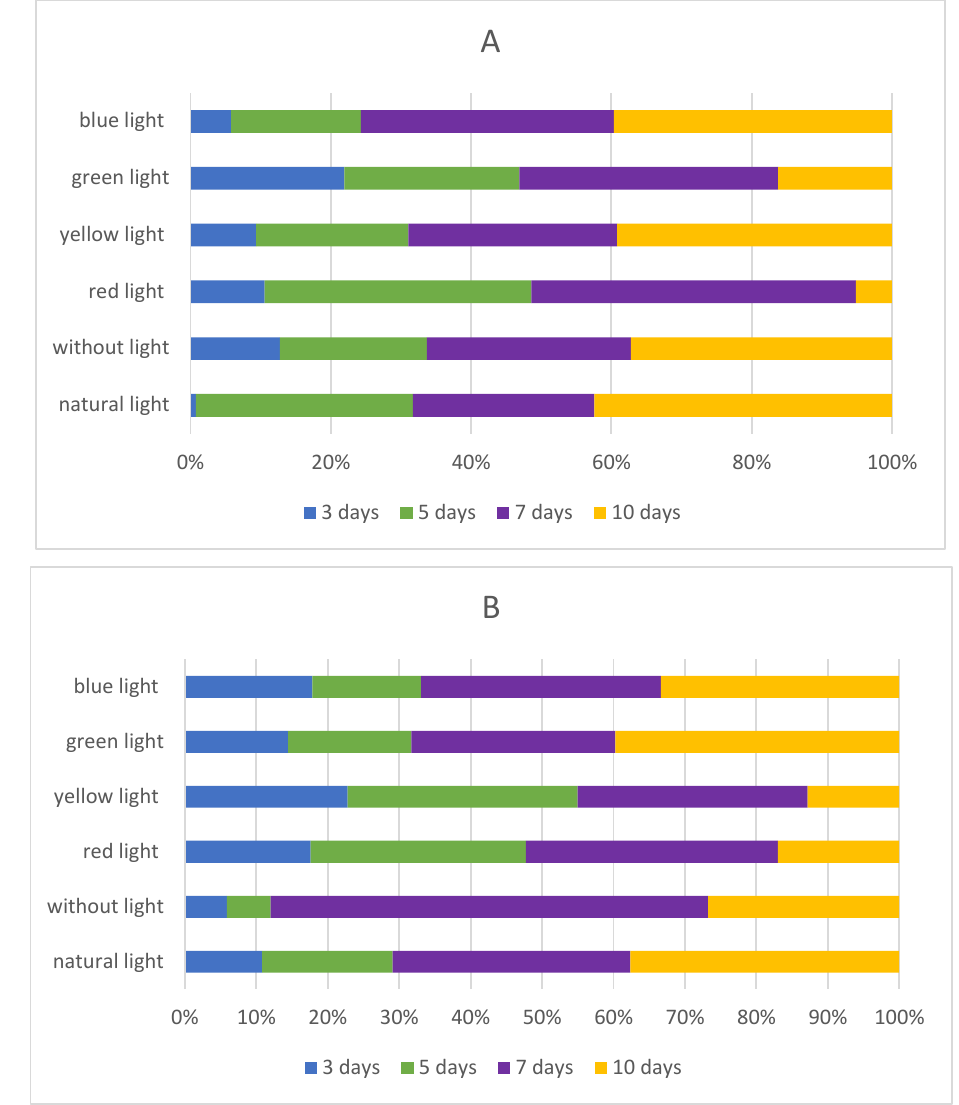
Figure 2. Cumulation dynamics of isoflavones sums [%] in chickpea ( A ), and lupin ( B ) sprouts harvested for 3, 5, 7, and 10 days.